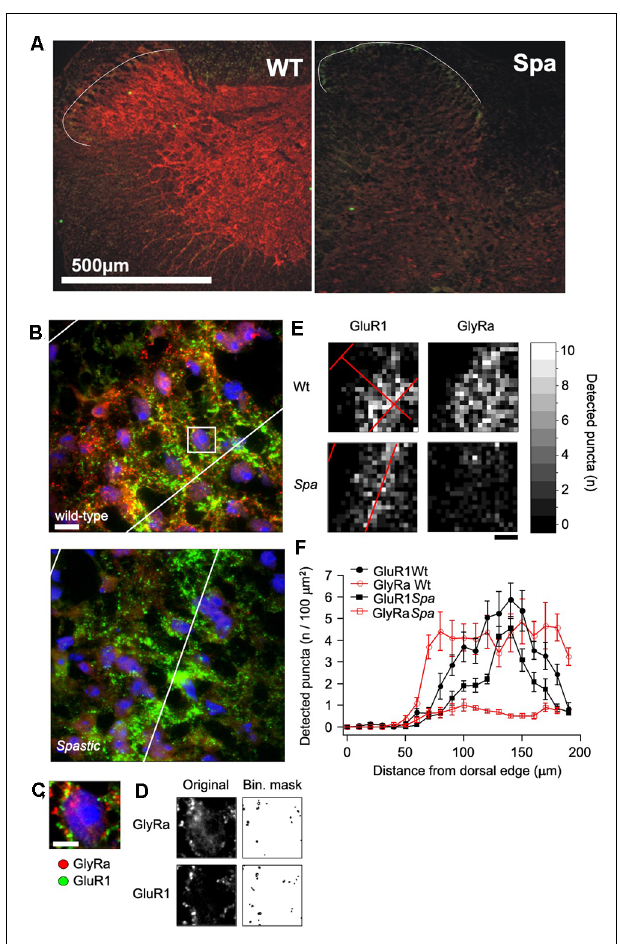
FIGURE 2 | Distribution of GlyR immunoreactivity in the spinal cord. (A) Confocal images of glycine receptor α -subunits (GlyRa; mAb4a; red) and AMPA receptors (GluR1; green) immunoreactivity in spinal cord sections of mice with the indicated genotype. The white line indicates the outer boundary of GluR1 fluorescence, which marks the superficial layers (layer I-III) of the sfdh. (B) Example of an immunoflourescence picture of the GlyR and GluR1 fluorescence in the sfdh that was used for quantification (Scale bar = 20 µ m). (C) Enlargement of the area within the presumptive layer II of the sfdh depicted in (B) . Note that all detectable immunofluorescence is localized in clusters. (D) Overview of GlyR α and GluR1 immunoreactive clusters detected by á-trous-wavelet transformation. (E) Spatial distribution of cluster densities in the confocal images presented in (B) . (F) Quantification of the cluster densities in relation to the distance from the surface of the sfdh given in 10 µ m